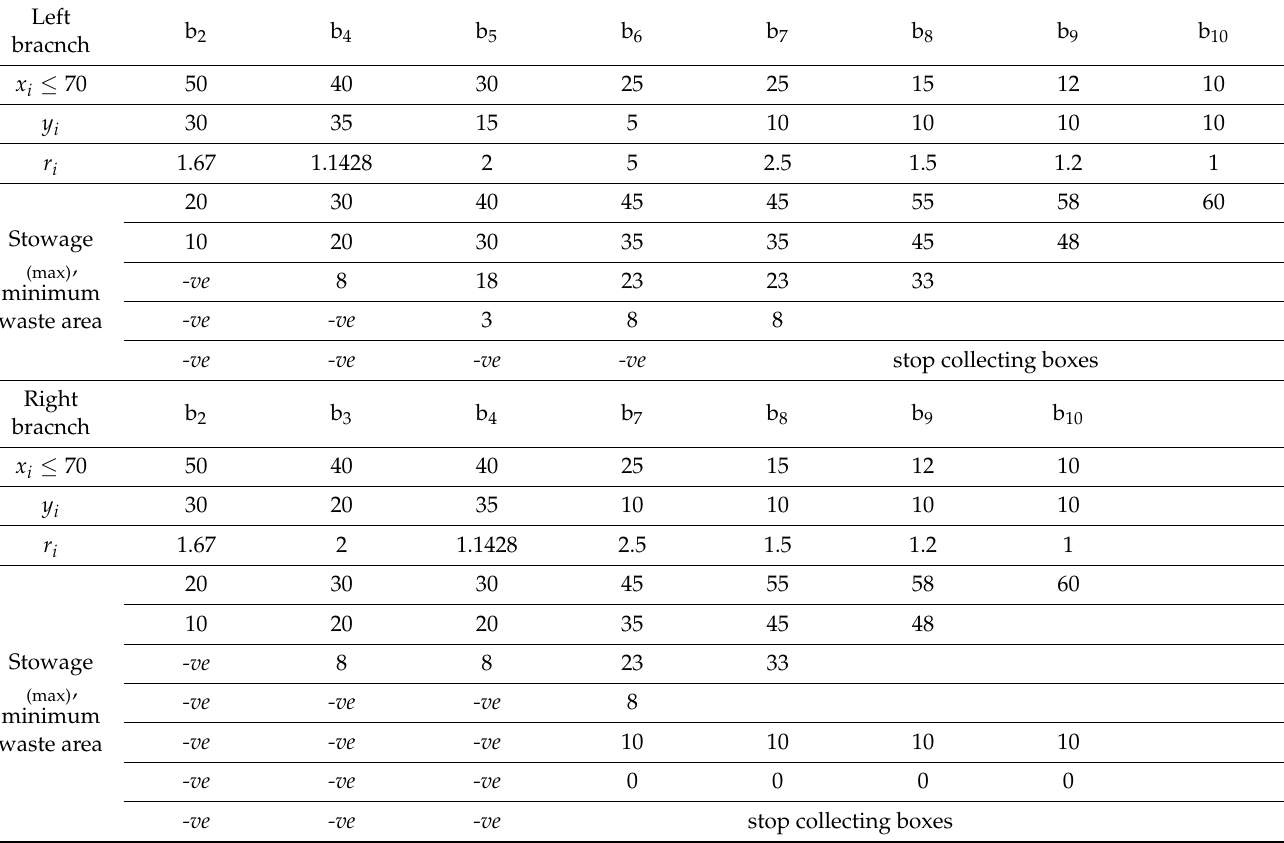
Table 9. Branch and bound for b i at X avi < 70.